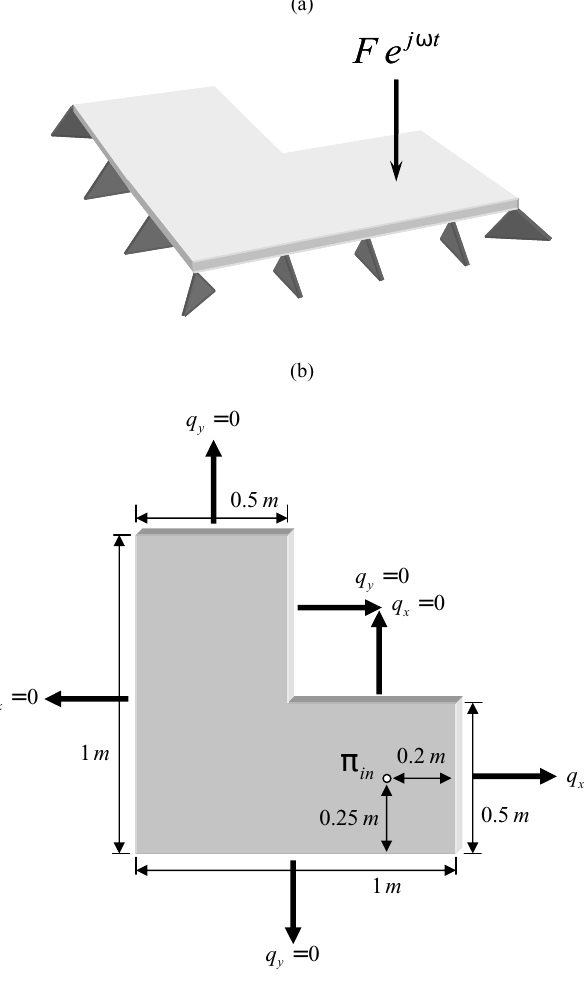
Fig. 11. Simply-supported L-shaped plate. (a) Geometry of plate with external transverse harmonic load. (b) Energy flow model with dimensions and zero energy flow boundary conditions. EFBEM offers a reliable result at high frequency. The results of Fig. 10(a) and 10(b) show that very light damping loss factor causes a large error; especially, when damping loss factor is 0.001, the error is about 2 × 10 − 6 . The error of EFBEM is mainly generated near the source and the boundary, and the error near the source is more than that near the boundary as the frequency and damping loss factor increase. The above results verify the accuracy of EFBEM and confirms that EFBEM can be efficiently applied for vibration problems of two-dimensional